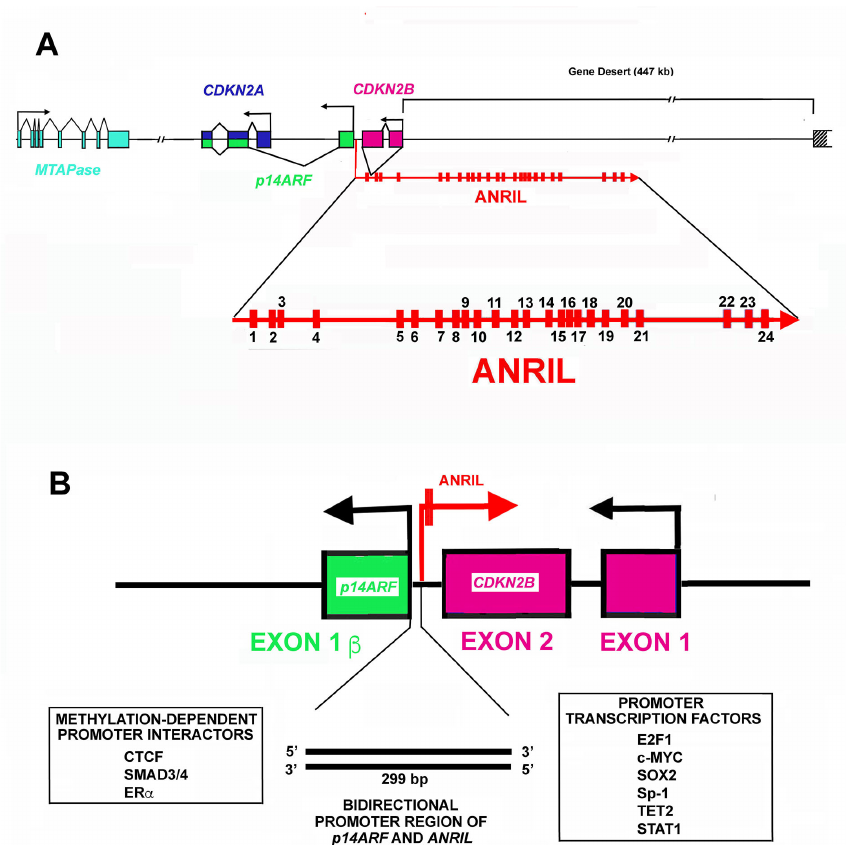
Figure 1. Structure of CDKN2A/CDKN2B locus. ( A ). The panel reports the organization in exons (rectangle) and introns (lane) and transcription direction of CDKN2A , CDKN2B , p14 Arf (p14ARF) and 5 ′‐ deoxy ‐ 5 ′‐ methylthioadenosine phosphorylase (MTAPase) genes. Note that the CDKN2A locus includes two different exons. In particular, exon 1 α (blue) is part of the CDKN2A gene, while the alternative exon 1 β (green) is part of the p14 Arf gene. The panel also shows the ANRIL gene structure and its transcriptional direction. As reported, the CDKN2B gene is localized in the first ANRIL intron. Finally, the figure highlights the gene desert where several enhancers are localized. ( B ). The panel reports the bidirectional promoter of the p14 Arf gene and the ANRIL gene. The promoter activity is regulated by several transcription factors listed at the bottom of the panel.